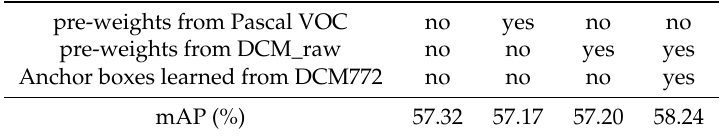
Table 5. A summary of results for character detection from pages on the DCM772 testing set. The model is trained on the DCM772 pages training